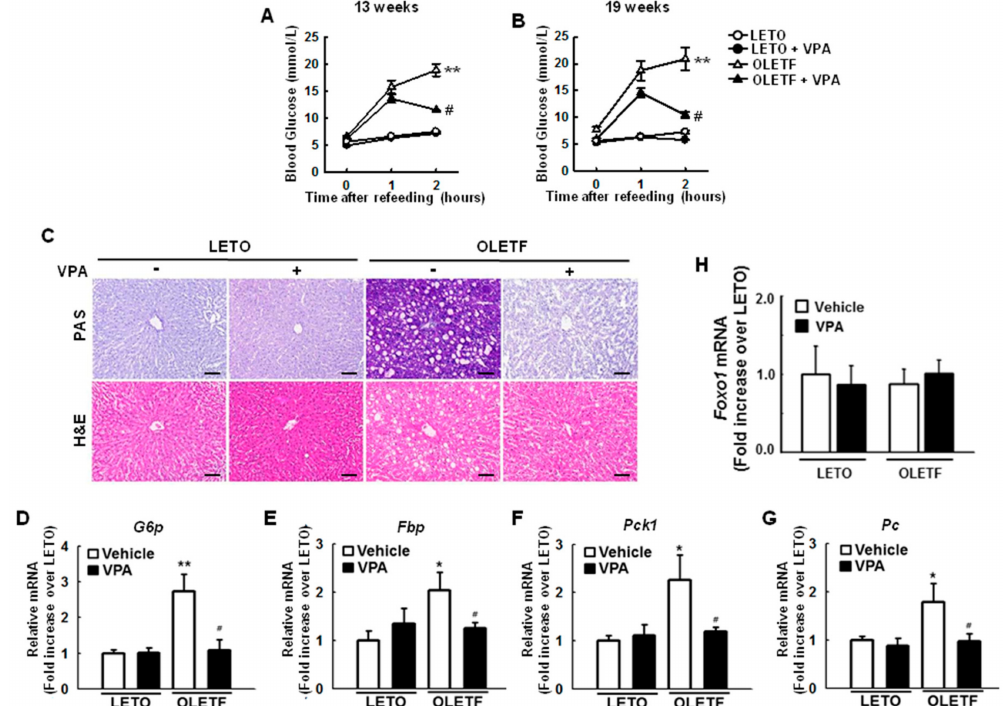
Figure 1. Sodium valproate (VPA) reduces gluconeogenesis in type 2 diabetic rats. ( A , B ) Blood glucose levels increased 1 and 2 h after re-feeding in Otsuka Long-Evans Tokushima Fatty (OLETF) rats, an effect that was ameliorated by VPA administration; ( C ) Glycogen accumulation was analyzed by periodic acid–Schiff (PAS) staining of liver tissues. Representative images show the effect of VPA administration on glycogen accumulation in liver tissues ( n = 6, scale bar = 50 µ m); Expression of gluconeogenic genes, such as glucose 6-phosphatase (( D ), G6p ), fructose-1, 6-bisphosphatase ( E , Fbp ), phosphoenolpyruvate carboxykinase (( F ), Pck1 ); and pyruvate carboxylase (( G ), Pc ) was quantified by reverse transcription-quantitative PCR. VPA administration decreased the expression of gluconeogenic genes in OLETF rats. Foxo1 mRNA was not significantly different between Long-Evans Tokushima Otsuka (LETO) and OLETF rats regardless of VPA treatment ( H ). The graphs show the mean ± standard error of mean (SEM) of six independent experiments. (* p < 0.05, ** p < 0.01 vs. Long-Evans Tokushima Otsuka (LETO) rats; # p < 0.05 vs. OLETF